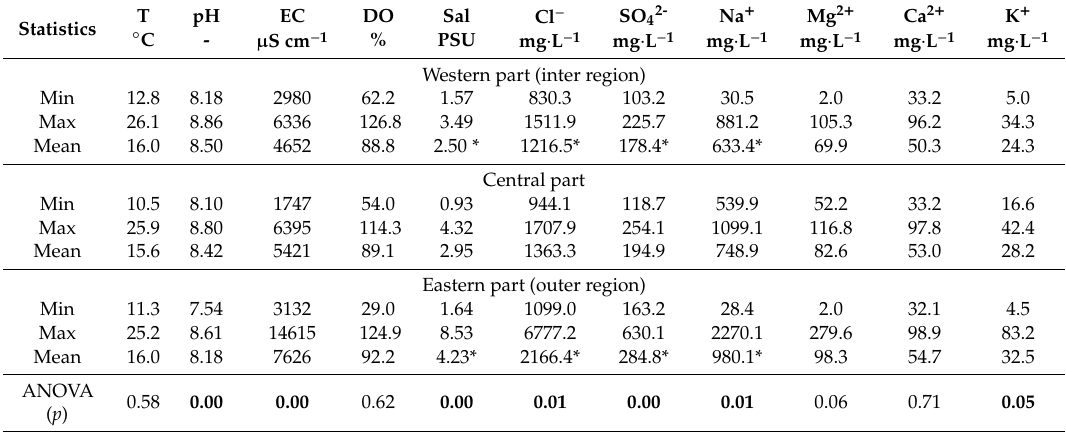
Table 2. Statistical summary of physicochemical variables of water in 2014–2015 in the western (inflow), central, and eastern (outflow) parts of Lake Łebsko with ANOVA